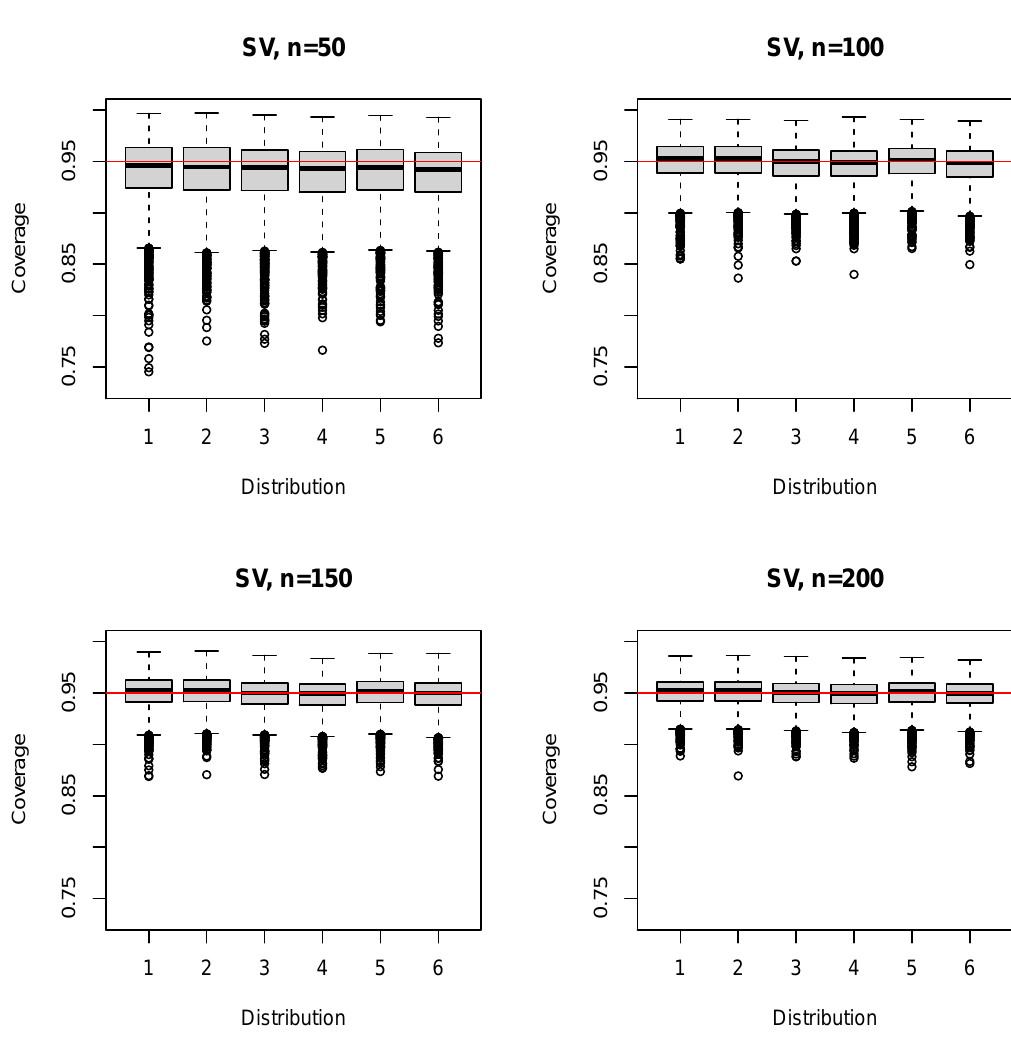
Figure 6. Boxplots of the coverage probability for the SV estimator and n = 50 ( 50 )